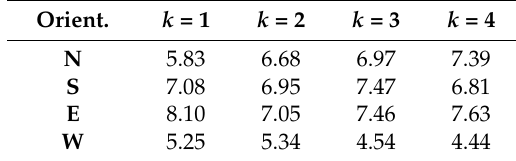
Table 2. Accuracy of Test 1: mean errors for different k and orientation values. Orient.